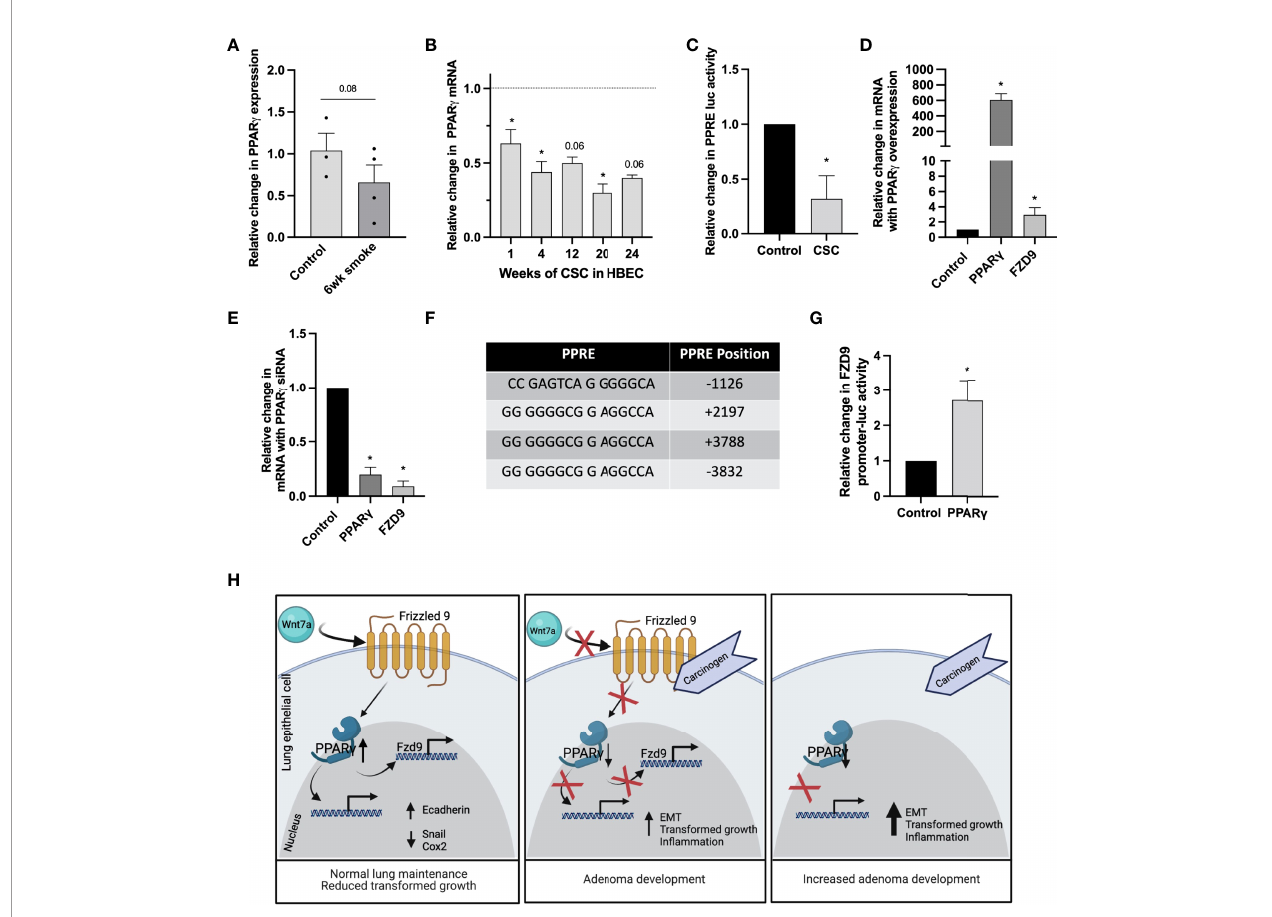
FIGURE 7 | Transcription of FZD9 is decreased by CSC and increased by PPAR g . (A) Change in PPAR g expression in mice after six weeks of exposure to cigarette smoke or ambient air control measured by qPCR. Results are normalized to RPS18 and measured in triplicate. (B) Change in PPAR g expression in HBEC3KT with 1-24 weeks exposure to CSC relative to DMSO control at each time point (dotted line), measured by qPCR. Results are normalized to GAPDH and conducted in triplicate. (C) Change in PPRE-luc activity after 48 hours of CSC exposure relative to DMSO control in HBEC3KT. Transfections and luciferase assays were conducted in triplicate. (D, E) Fold change in PPAR g and FZD9 expression in HBEC3KT measured by qPCR after transfection in triplicate with (D) PPAR g or (E) PPAR g siRNA. Results are normalized to GAPDH, relative to control, and conducted in triplicate. (F) Putative PPREs in the TSS- fl anking region of FZD9. (G) FZD9 promoter luciferase activity vs control in HBEC3KT after transfection with a PPAR g plasmid. (H) Diagram of the effects of carcinogen exposure and Fzd9 loss in lung epithelial cells. Diagram created with Biorender.com. Transfections and luciferase assays were conducted in triplicate. Statistical signi fi cance was determined by a two-tailed t-test or one-way ANOVA with Tukey ’ s post hoc analysis and *p<0.05. CSC, cigarette smoke